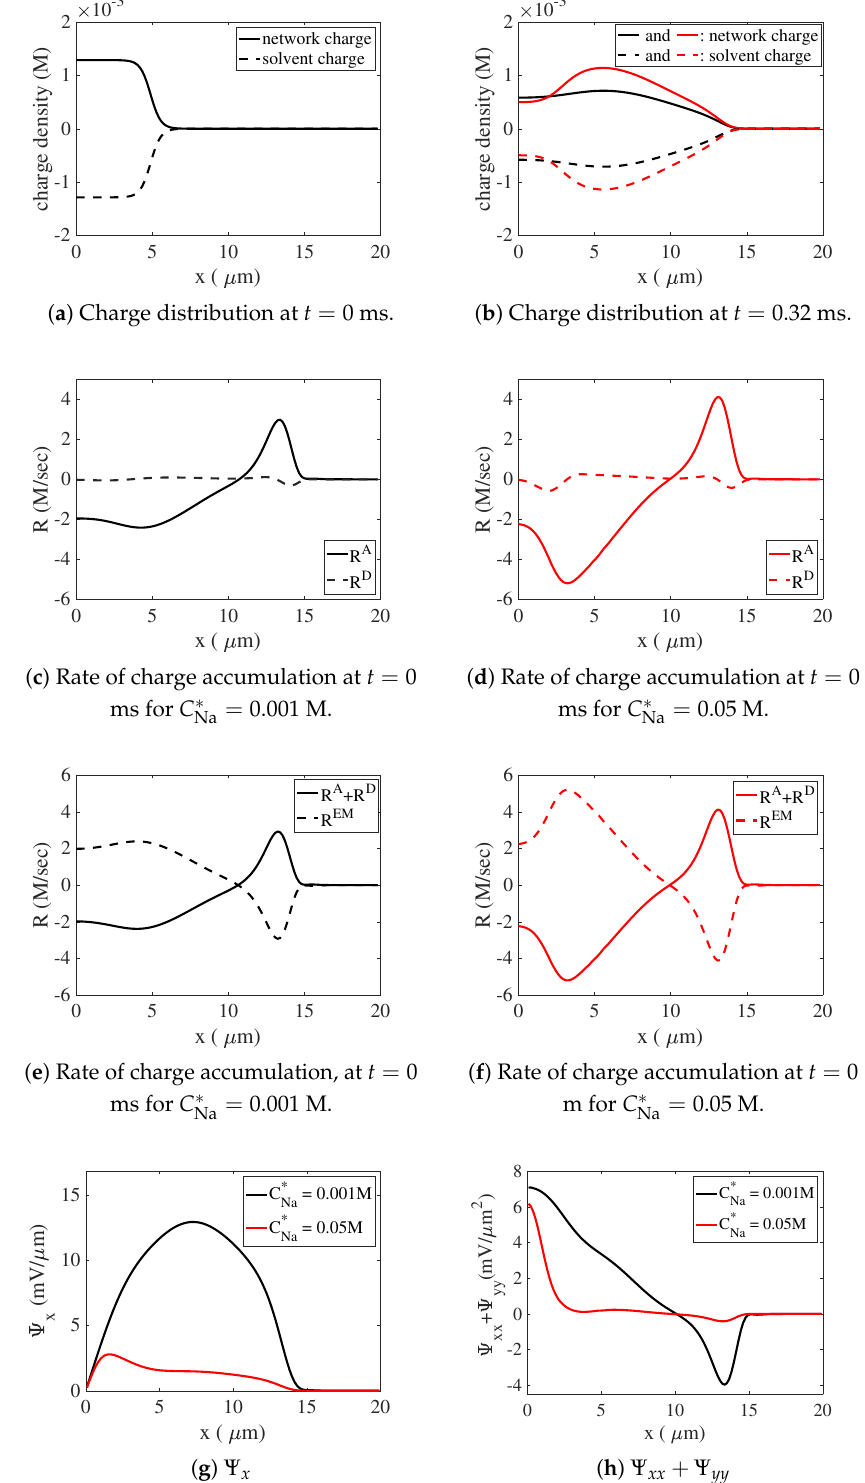
Figure 8. Distribution of charge-related variables along the positive x -axis. ( a ) Initial charge distribu- tions on the network and solvent. All other plots are at t = 0.32 ms. ( b ) Charge distributions on the = 0.001 M and C ∗ = 0.05 M. ( c , d ) The rates of charge accumulation due network and solvent C ∗ Na Na to advective and diffusive transport of charged species. ( e , f ) The rates of charge accumulation due to the combination of advection and diffusion and to electromigration. The variation of ( g ) Ψ x and ( h ) Ψ xx + Ψ yy along the positive x